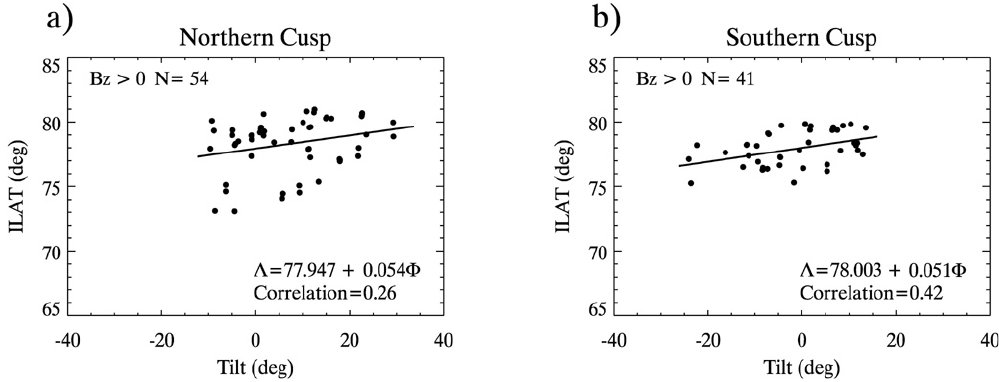
Fig. 3. The ILAT of the cusp location versus dipole tilt angle for cusp crossings corresponding to northward IMF, (a) for the northern cusp, (b) for the southern